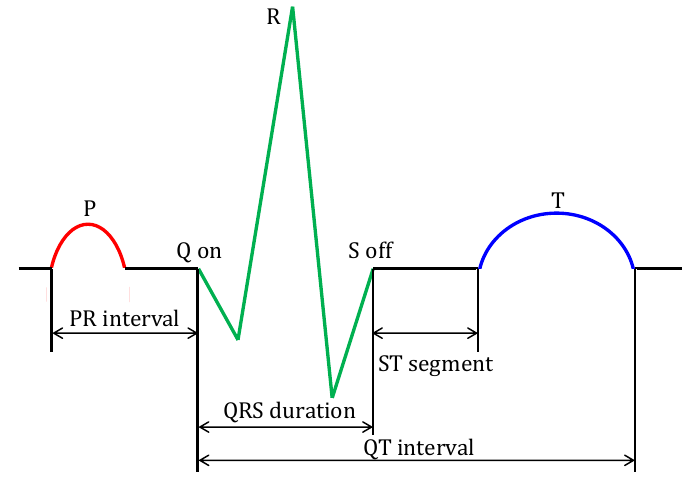
Figure 2. Composition of ECG